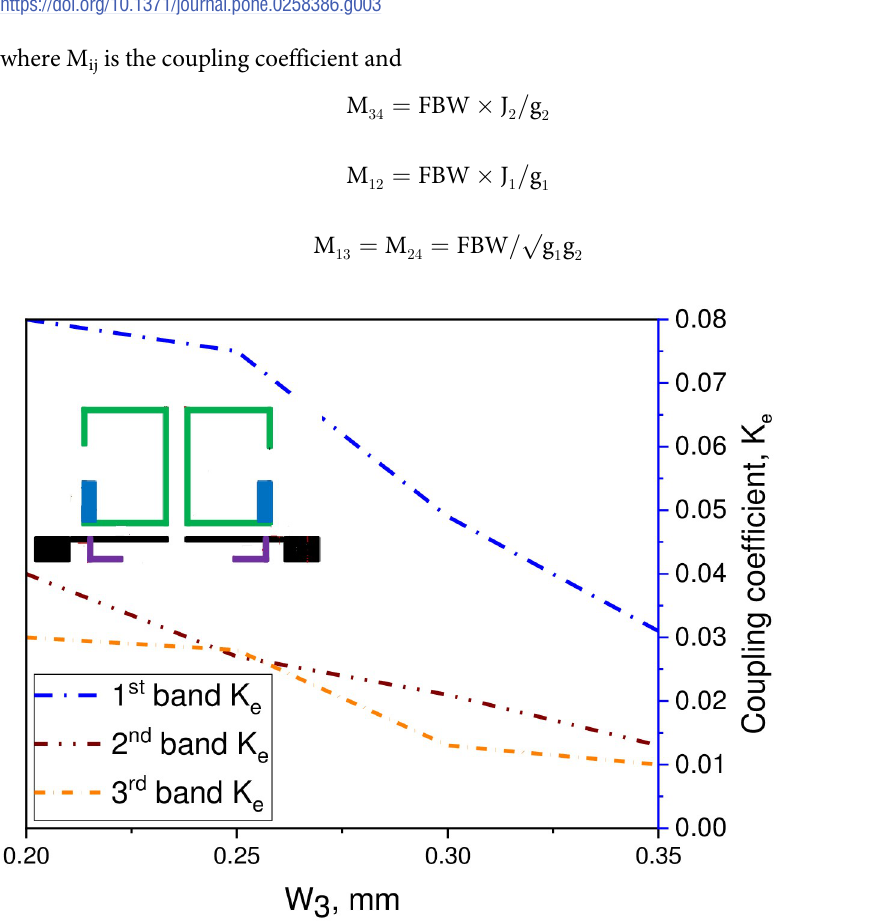
Fig 4. Graph of coupling coefficient with W 3